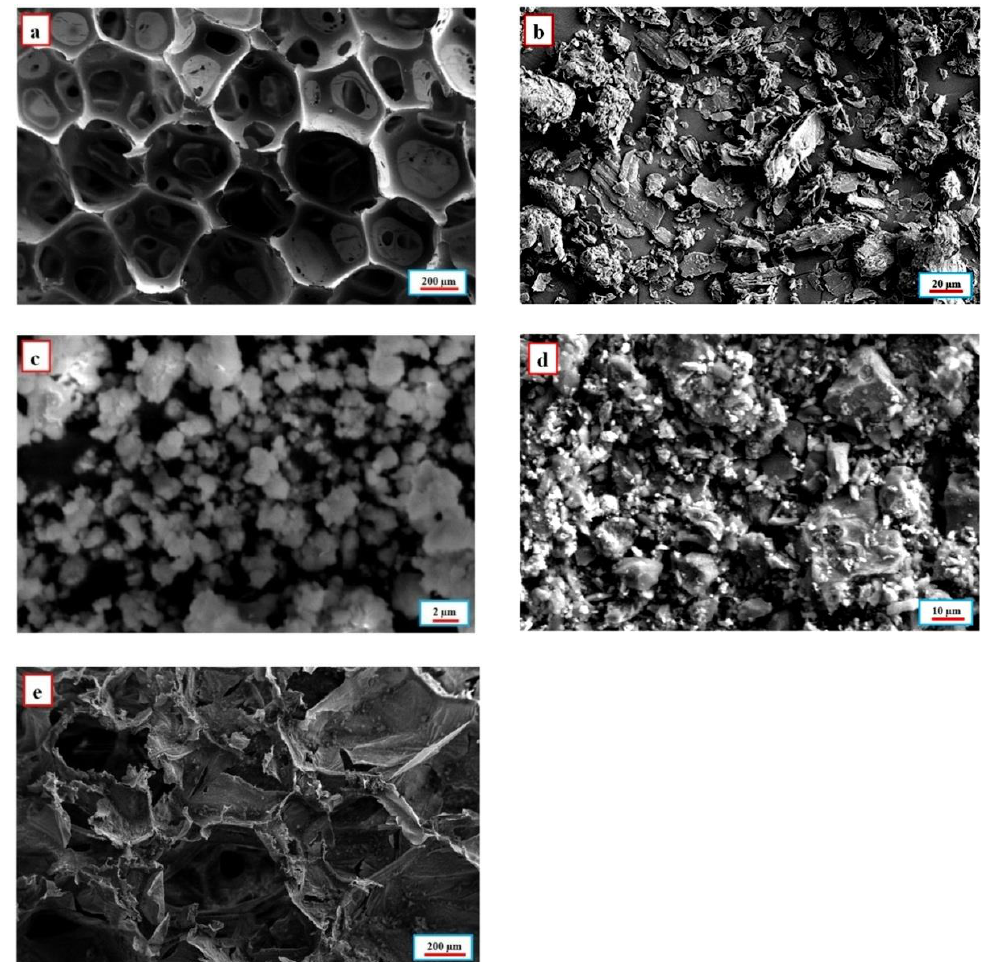
Figure 3. FESEM characterization of ( a ) Open cellular pores of bio-based flexible polyurethane foam, ( b ) Graphite nanoplates, ( c ) Zirconium oxide nanoparticles, ( d ) Bamboo charcoal nanoparticles, ( e ) Nanoparticle-reinforced flexible bio-based polyurethane foam.